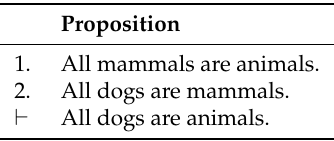
Table 2. A valid syllogism: aaa